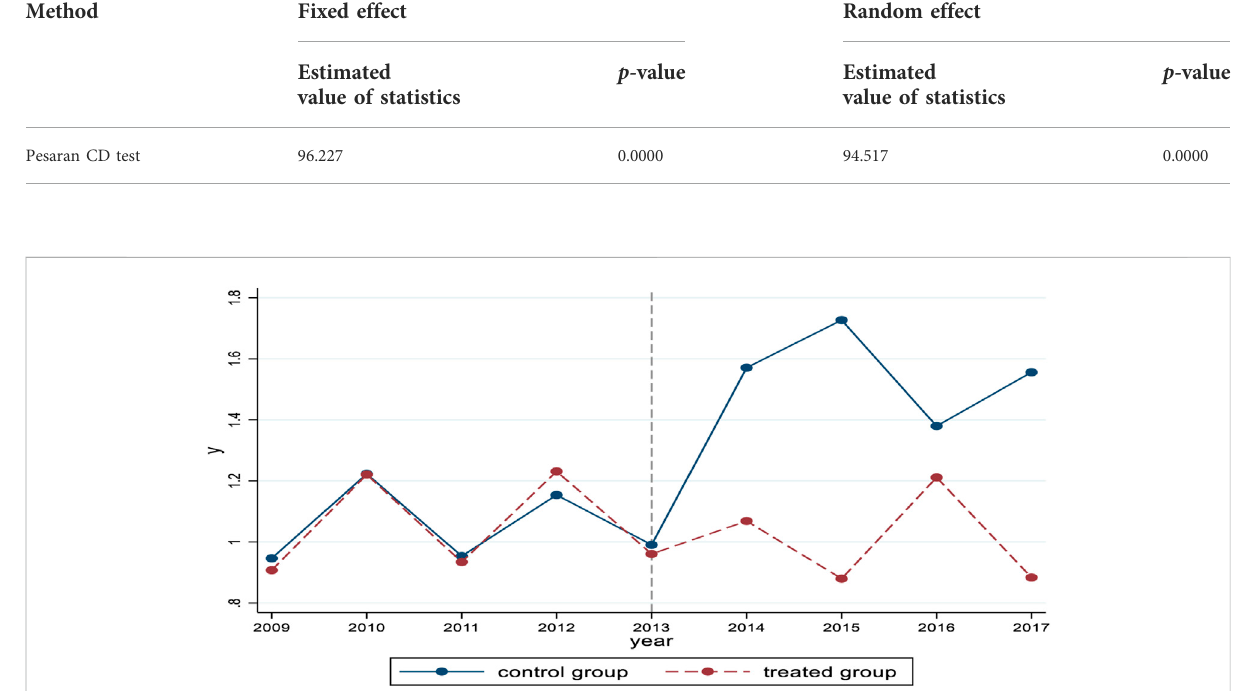
FIGURE 1 Parallel trend